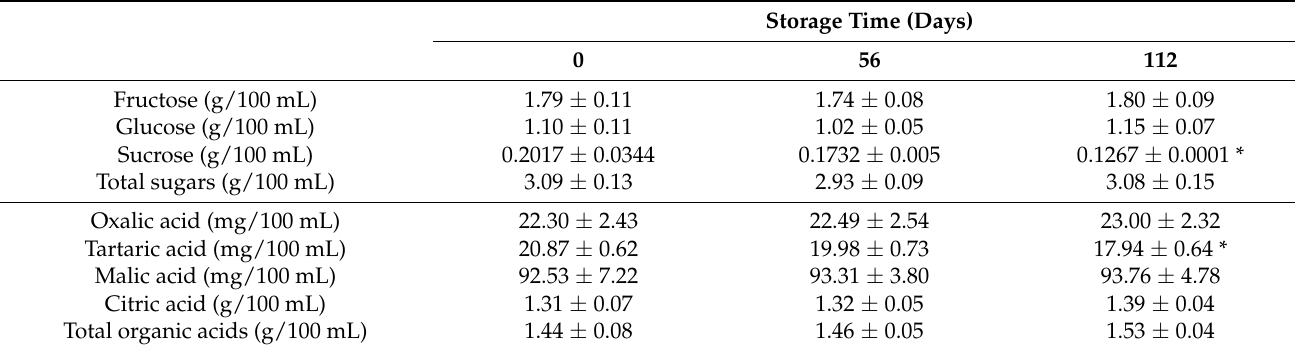
Table 1. Sugars and organic acids contents of unsweetened jaboticaba juice stored at 25 ◦ C for 112